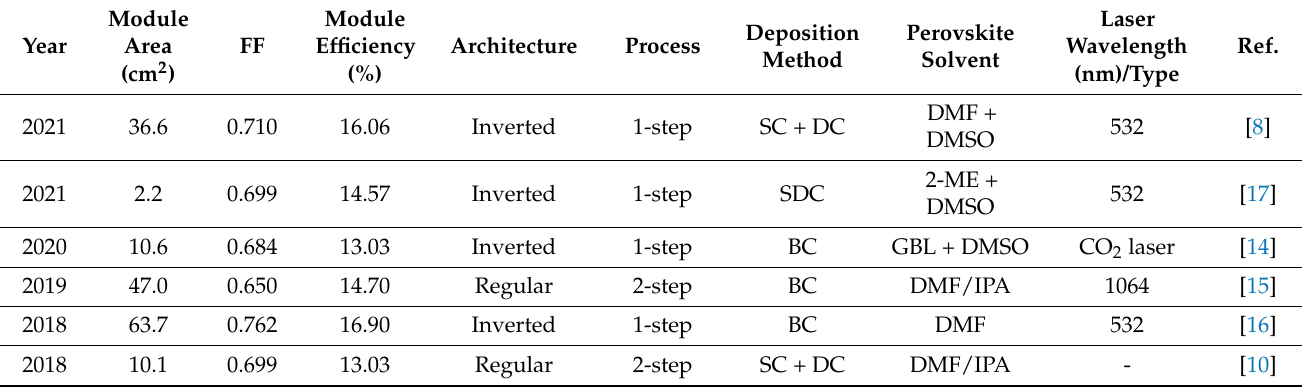
Table 1. Selected PSM papers and their